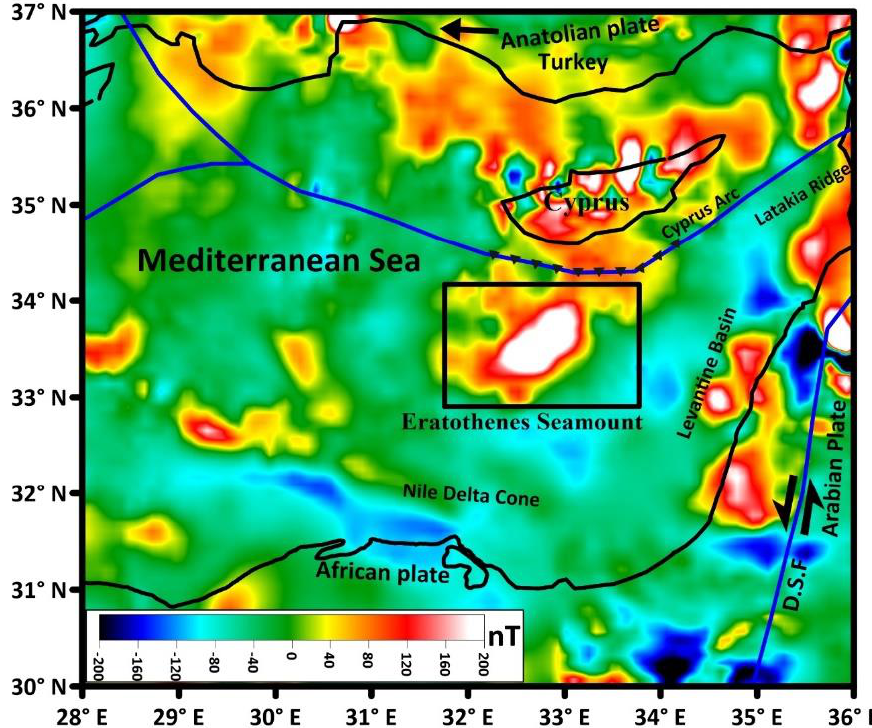
Figure 3. Reduction to pole (RTP) magnetic anomaly map. The contour interval is 40 nT.